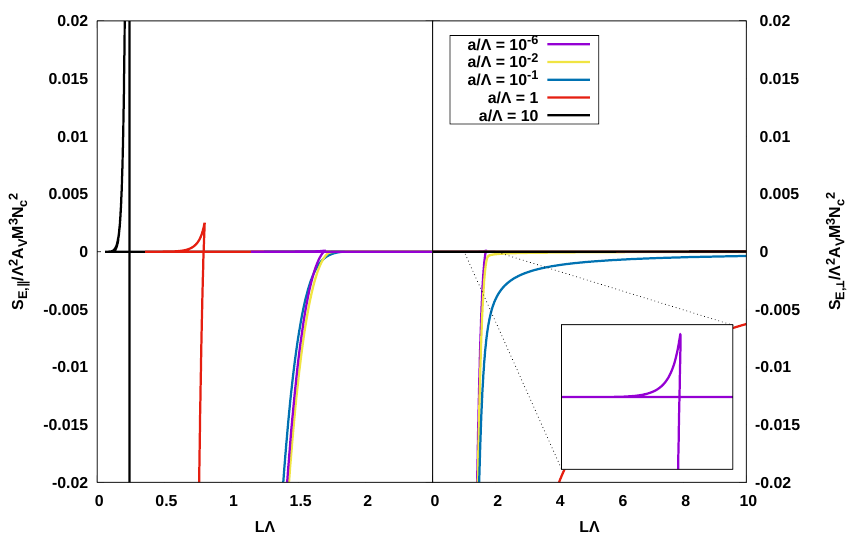
and S E; ? for the respective regions described in section 5.4 E; k